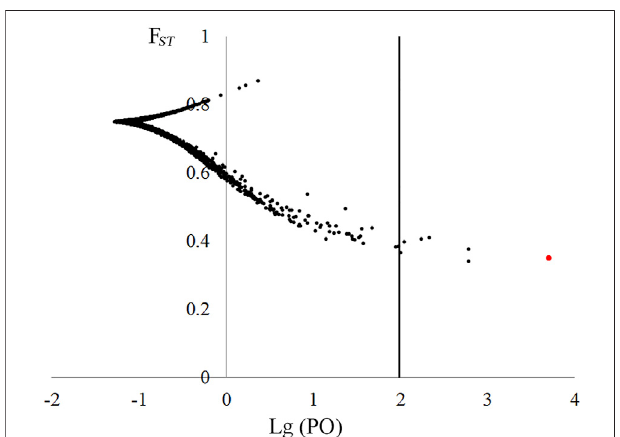
FIGURE 4 | Plot of F ST values and log10(PO) for 40,751 non-neutral loci based on BayeScan outlier test. Loci in the right of the dashed line (log10[PO] (cid:1) 2) were deemed as under selection with a posterior probability >